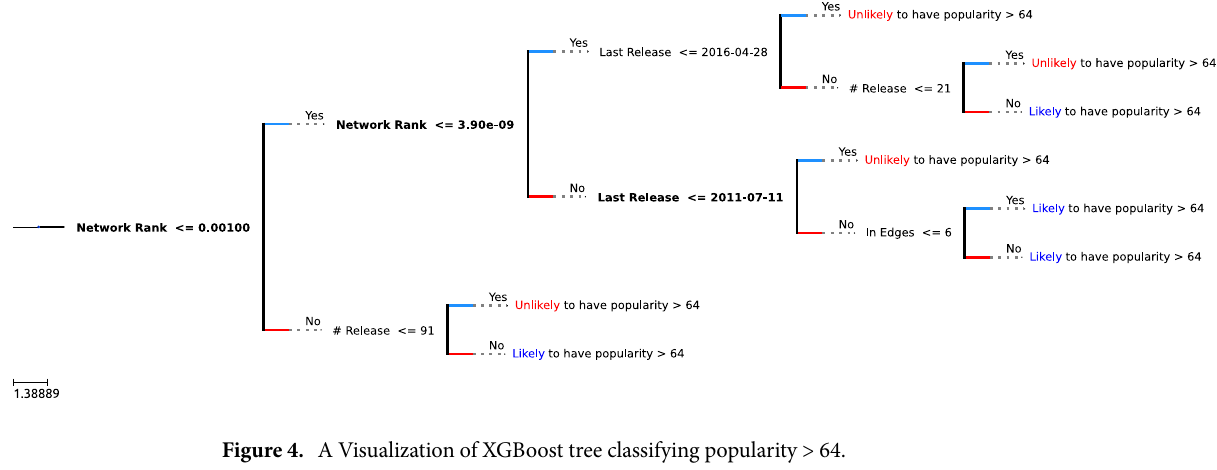
Figure 4. A Visualization of XGBoost tree classifying popularity >